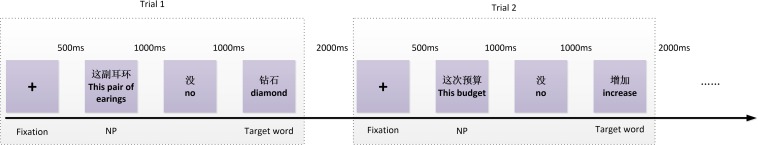
Trial procedure. Each trial contains one sentence.